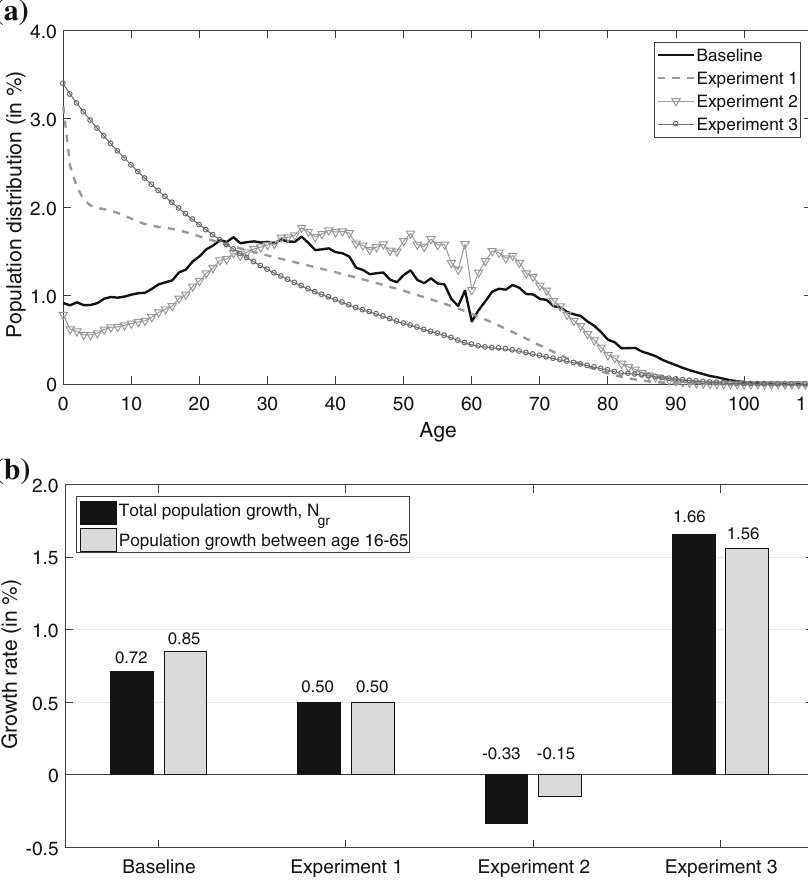
Fig. 8 Population characteristics under different experiments, Spain 1850–2000. a Population distribution inyear2000, N j , 2000 / N 2000 and b populationgrowthratesfrom1850to2000. Source Authors’calculation. Notes Experiment 1 assumes a fixed TFR around 5 and a life expectancy at birth of 31.5years.